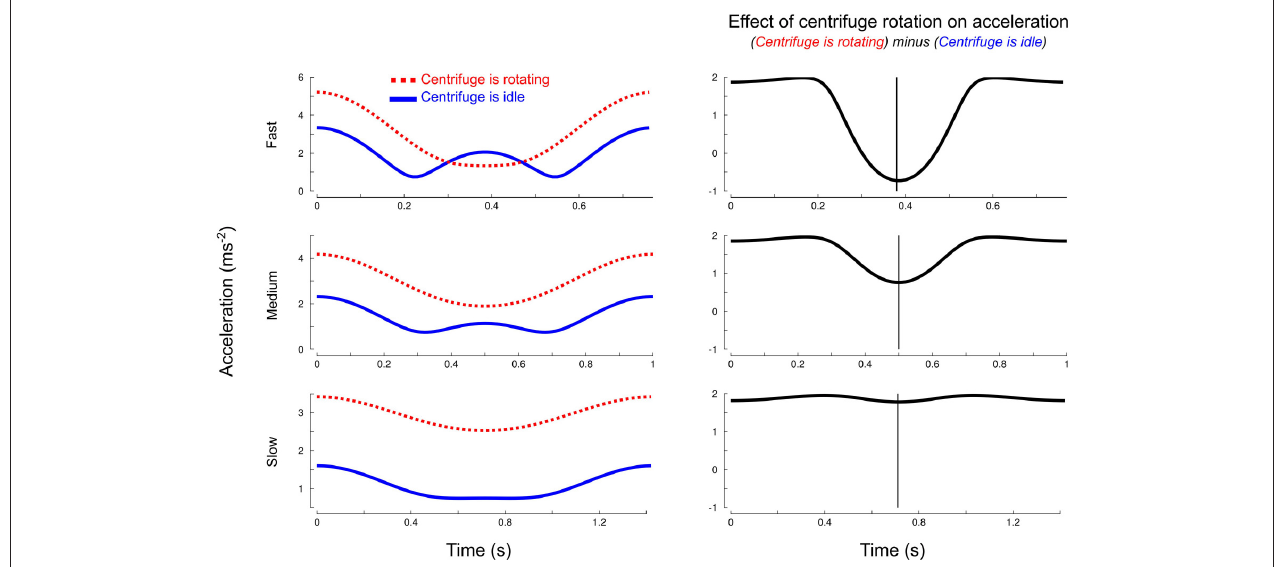
FIGURE 2 | Simulated effects of centrifuge rotation on the magnitude of total object acceleration over time. Left column: total resultant acceleration ( kE g + E v 2 R + E a m k , red dotted trace) and resultant acceleration without taking into account the centripetal acceleration ( kE g + E a m k , blue solid trace) for each pace (three rows). Right column: magnification of the effects of centrifugation by subtracting kE g + E a m k from kE g + E v 2 R + E a m k . The vertical cursor marks the largest discrepancies between the two accelerations.